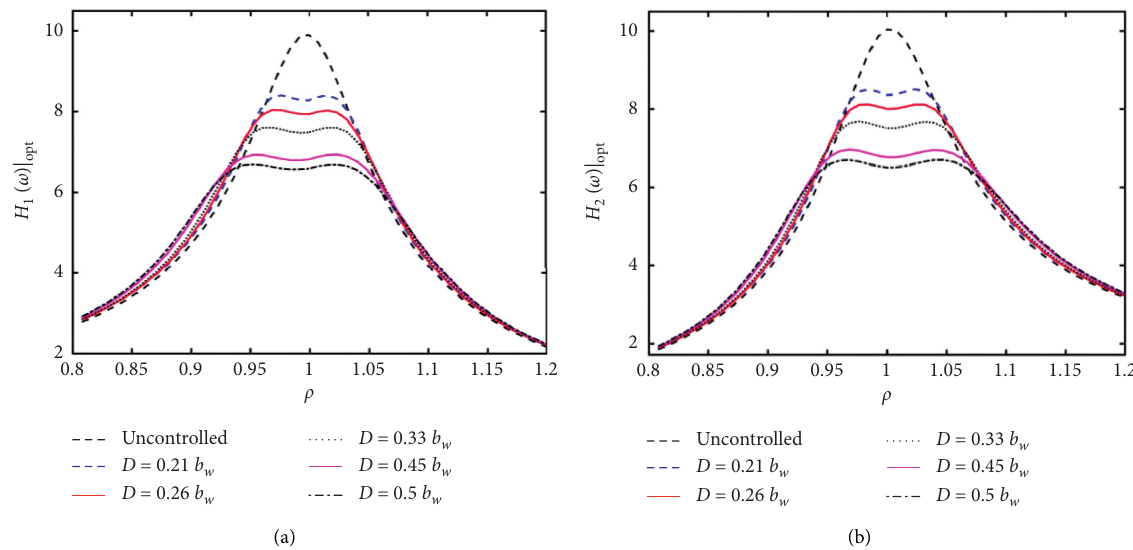
Figure 6: Transfer functions plot of 6-vertical column TLMCDs with various column diameter: (a) transfer function of displacement and (b) transfer function of acceleration.